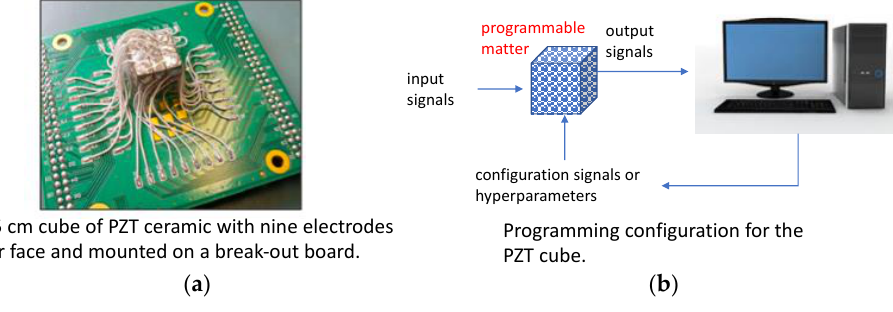
Figure 2. ( a ) The unpoled PZT cube mounted on a breakout board. ( b ) Schematic of the concept for using the cube for computation.